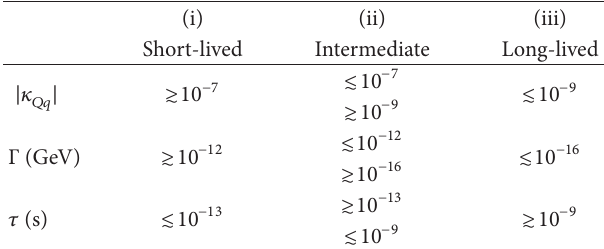
Table 4: Possible decay signatures for new long-lived quarks ( 𝑚 𝑄 = 1 TeV/ 𝑐 2 ), as discussed in the text.